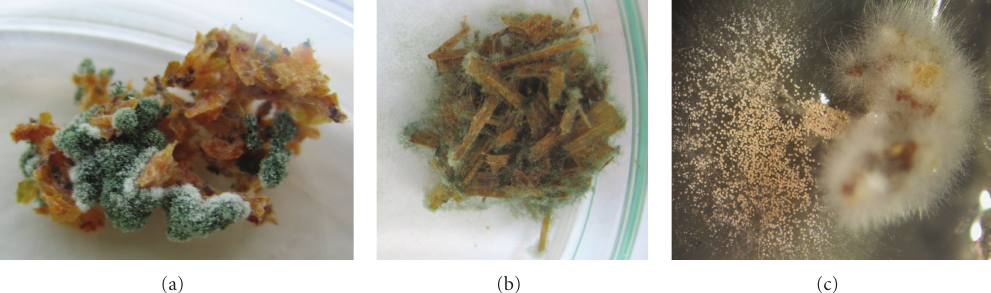
Figure 3: Fungus garden fragments of leaf-cutting ants overgrown by filamentous fungi. (a) Atta texana garden fragment (TX, USA) with green tufts of Trichoderma sp. (b) Atta bisphaerica garden fragment (Botucatu, Brazil) with green conidiation of Trichoderma sp. Workers from (a) and (b) were manually removed and garden fragments were kept in wet chambers for 5 days at 25 ◦ C. (c) Isolation plate showing fungus garden fragment on potato dextrose agar medium supplemented with 150 µ g · mL − 1 of chloramphenicol. On the right note the white mycelia of the mutualistic fungus of attine ants and on the left the microfungus Aspergillus sp. Both fungi emerged from the garden fragment.